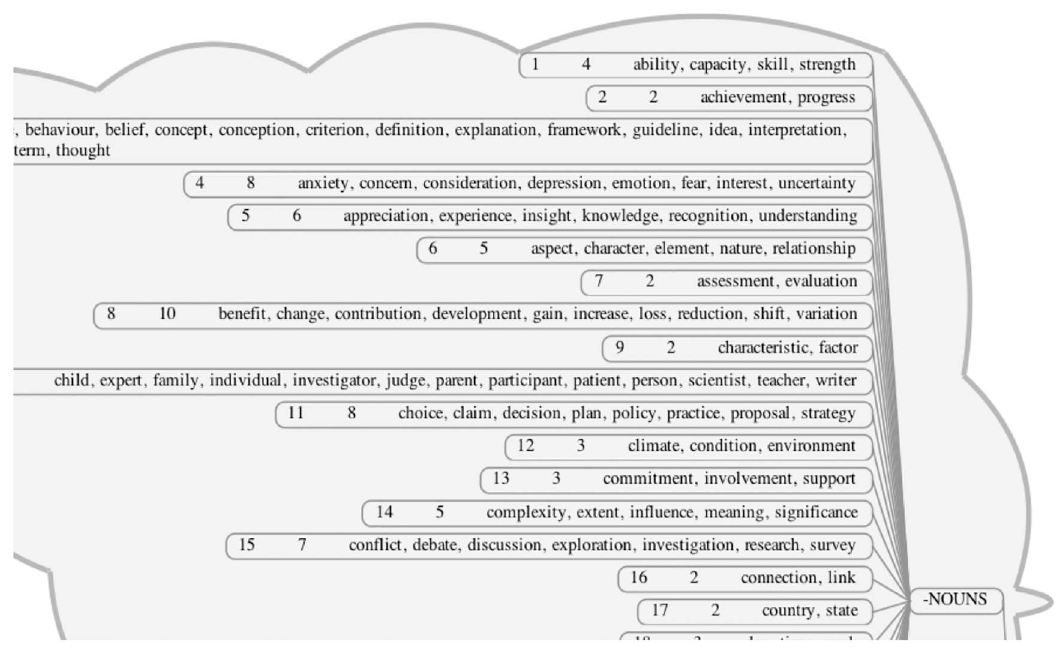
Fig 5. Sample of clusters produced by the Chinese Whispers clustering